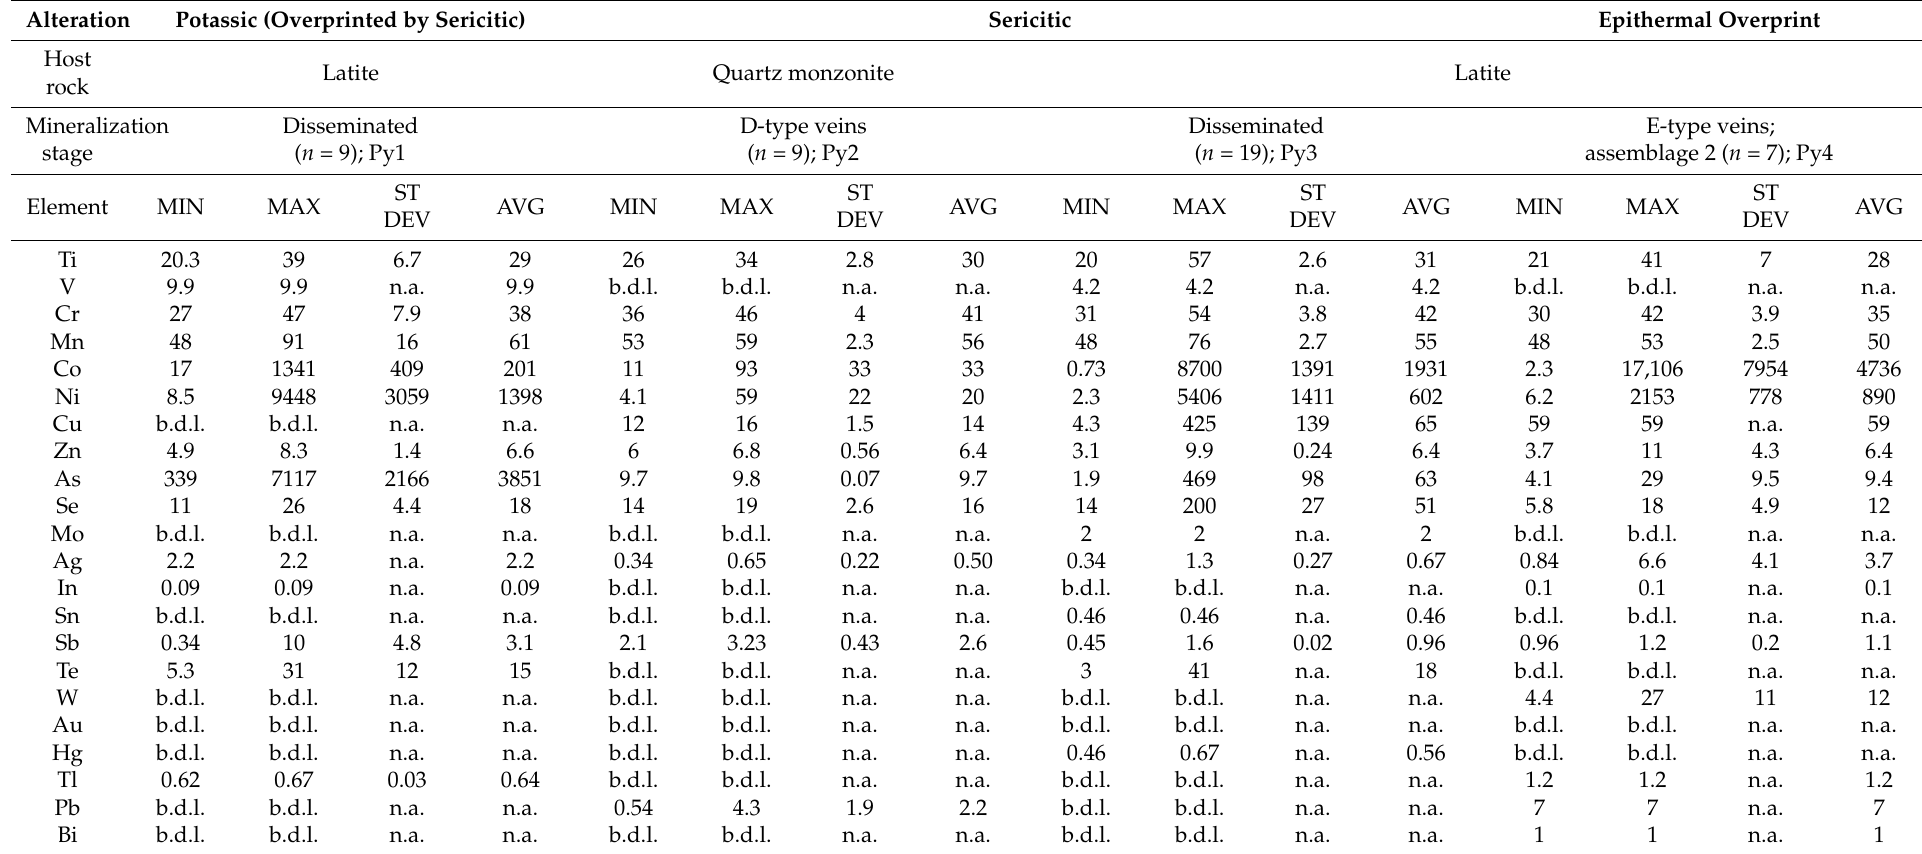
Table 3. LA-ICP-MS analyses of pyrite from various mineralization stages. Values are in ppm. For the full dataset, see Supplementary Table S3.